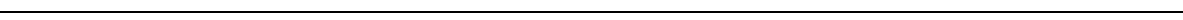
Fig. 4 Vps3 and Vps8 are required for recycling of β 1 integrins but not Tf. a HeLa cells knocked down for Vps3, Vps8 or Vps3/8 were incubated with green fl uorescent dextran and red fl uorescent Tf for 2 h and visualised by fl uorescence microscopy. b Quanti fi cation of a , co-localisation analysis from three separate experiments with n > 40 cells showed no block of Tf recycling. Error bars represent SD. c Integrin recycling assay as described 34 . HeLa cells knocked down for Vps3/8 were serum-starved overnight and labelled with anti- β 1 integrin on ice. After 2 h uptake at 37 °C, followed by fi xation and labelling with fl uorescent secondary antibodies, β 1 integrin accumulation in REs (arrows) was visualised by IF. In knockdown cells, no accumulation of integrin was found, indicating that the traf fi cking to REs is blocked. d IEM of cells subjected to the integrin uptake assay as in c and immunogold-labelled for endocytosed anti- β 1 integrin (10 nm gold). Accumulations of endocytosed β 1 integrin are by IEM identi fi ed as a cluster of tubular membranes (left panel, cluster accented by white dashed line, inset shows magni fi cation of membrane tubules). In knockdown cells, internalised β 1 integrin were found in EEs and associated vesicles (right panel, arrows). Bar, 200 nm. e Quanti fi cation of Supplementary Fig. 7, indicating the percentage of cells with accumulation of β 1 integrins in the RE. n = 300 cells per time point from three separate experiments. Error bars represent SD. f ELISA-based recycling assay of surface- biotinylated α 5 integrin as described 35 . HeLa cells knocked down for Vps3/8 show a decrease in recycling of α 5 β 1 integrin compared to the control. Error bars represent SD. g Internalisation of integrins measured using the ELISA data of f . The experimental replicates were compared using the ratio between Vps3/8 KD and scrambled cells. The ratio of ~1.0 indicates no signi fi cant difference in internalisation between conditions. Error bars represent SD. h IEM of HeLa cells loaded with BSA-Au5 expressing GFP-Vps3. GFP-Vps3 (10 nm gold) co-localises with the endogenous β 1 (15 nm gold, left panel) and α 5 integrin subunits (15 nm gold, right panel). Bar, 100 nm. PM plasma membrane, E endosome, EE early endosome, N nucleus, M